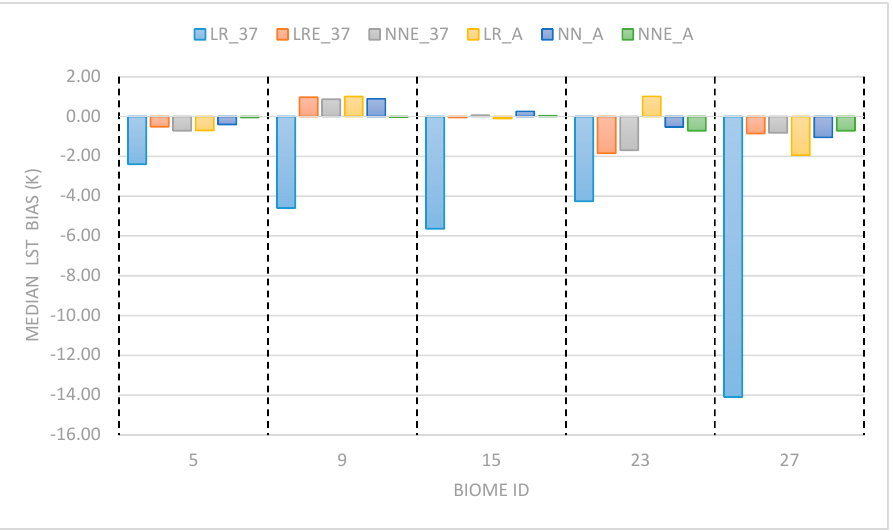
Figure 10. The median LST biases for each of the MW algorithms for the five most frequent biomes in the dataset. ( 5 ) closed to open broadleaved evergreen and/or semi-deciduous forest; ( 9 ) open needleleaved deciduous or evergreen forest; ( 15 ) sparse vegetation; ( 23 ) bare areas of soil type Aridisols—Calcids; ( 27 ) permanent ice.